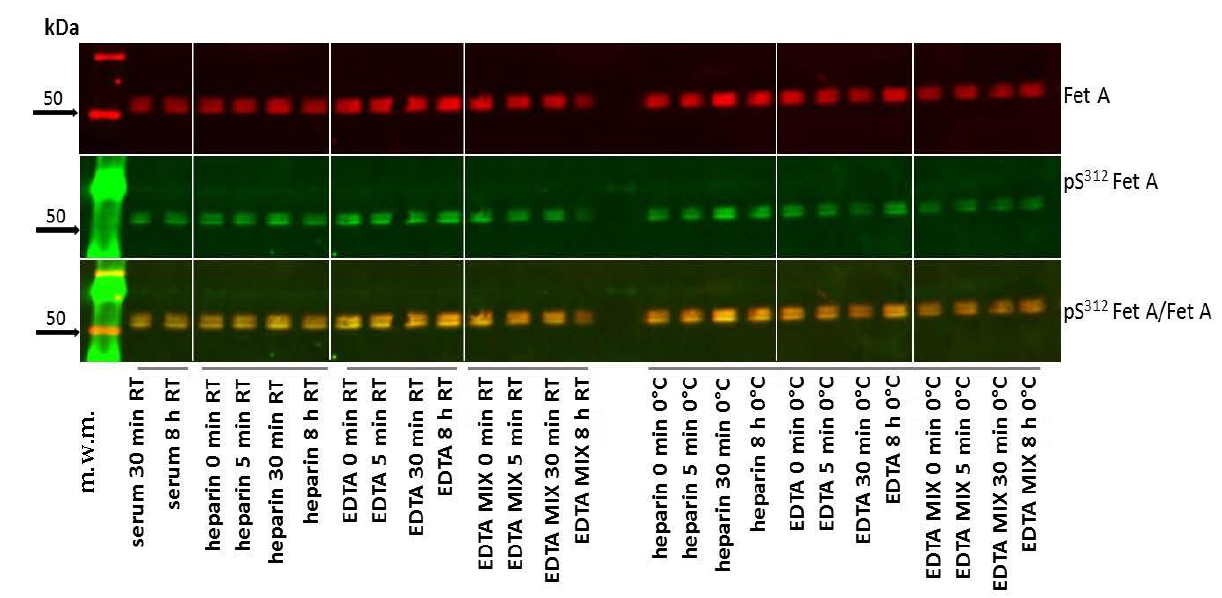
Figure 2. Stability of pSer 312 Fet A in human blood samples collected in different routine blood tubes at Western blot analysis of blood samples from a healthy volunteer and the stability of pFet A was evaluated in sample material used in routine clinical chemistry. Blood samples were collected in tubes containing different additives i.e., heparin, EDTA, and EDTA mixture as described in the method section. Bold arrows indicate molecular weight marker (m.w.m).